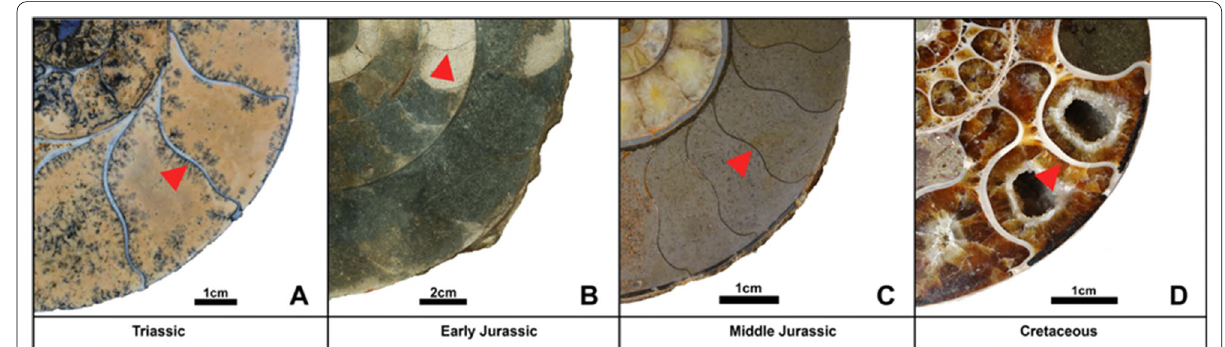
Fig. 7 Examples of different septal thickness ranges corresponding to their time period. The figure shows mainly two different septal thicknesses. Ammonoids from the Late Triassic and the Early Cretaceous show a greater septal thickness than those from the Early and Middle Jurassic. A Rhacophyllites neojurensis (Phylloceratidae); B Arietites sp. (Arietitidae); C Ludwigia bradfordensis (Graphoceratidae); D Argonauticeras besairei (Lytoceratidae). Well discernible examples of septa are indicated by red